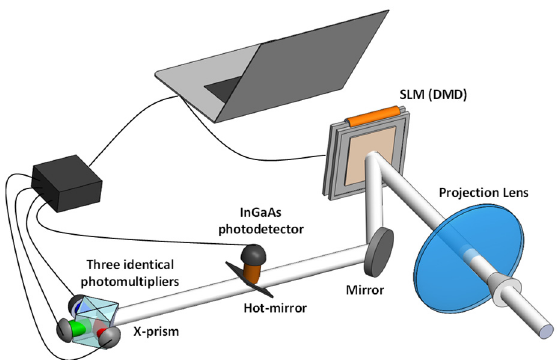
Figure 14. The schematic drawing of a DMD-based single-pixel imaging system to capture the visible images and infrared images at the same time [87].